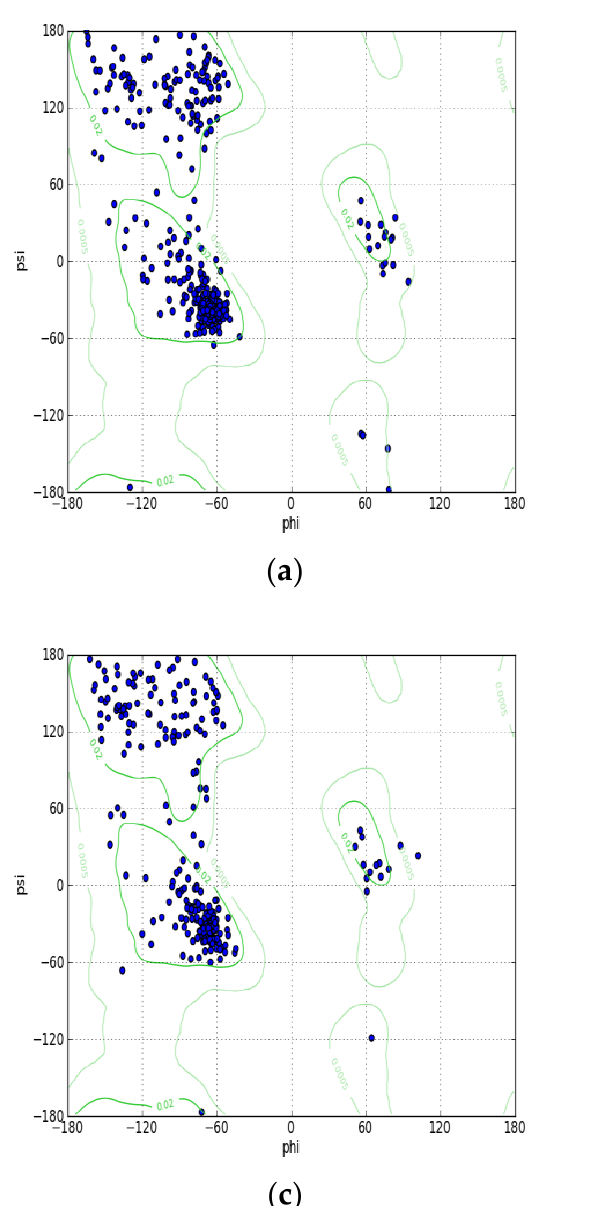
Figure 2. The Ramachandran plot analysis of the protein structures: ( a ) The Ramachandran plot for Yeast protein . Highly preferred observations are: 370 (97.113%). Preferred observations are: 10 (2.625%). Questionable observations are: 1 (0.262%). ( b ) The Ramachandran plot for XP protein. Highly Preferred observations are: 244 (95.686%). Preferred observations are: 10 (3.922%). Question- able observations are: 1 (0.392%). ( c ) The Ramachandran plot for XM protein. Highly preferred ob- servations are: 240 (96.386%). Preferred observations are: 8 (3.213%). Questionable observations are: 1 (0.402%).